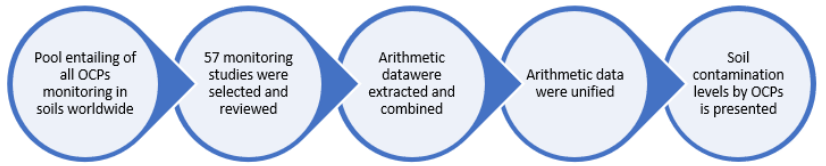
Figure 4. The concept of data analysis and processing of the available monitoring studies.